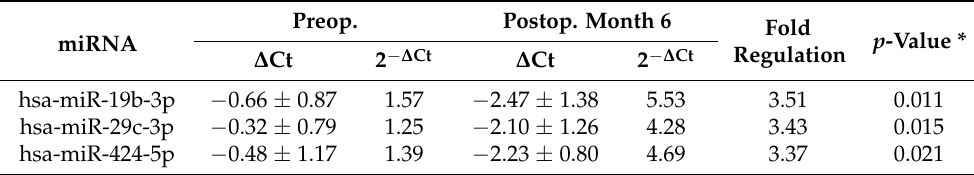
Table 5. 3 miRNAs showing significant fold change at profiling stage. Preop. Postop. Month 6 Fold miRNA ∆ Ct 2 − ∆ Ct